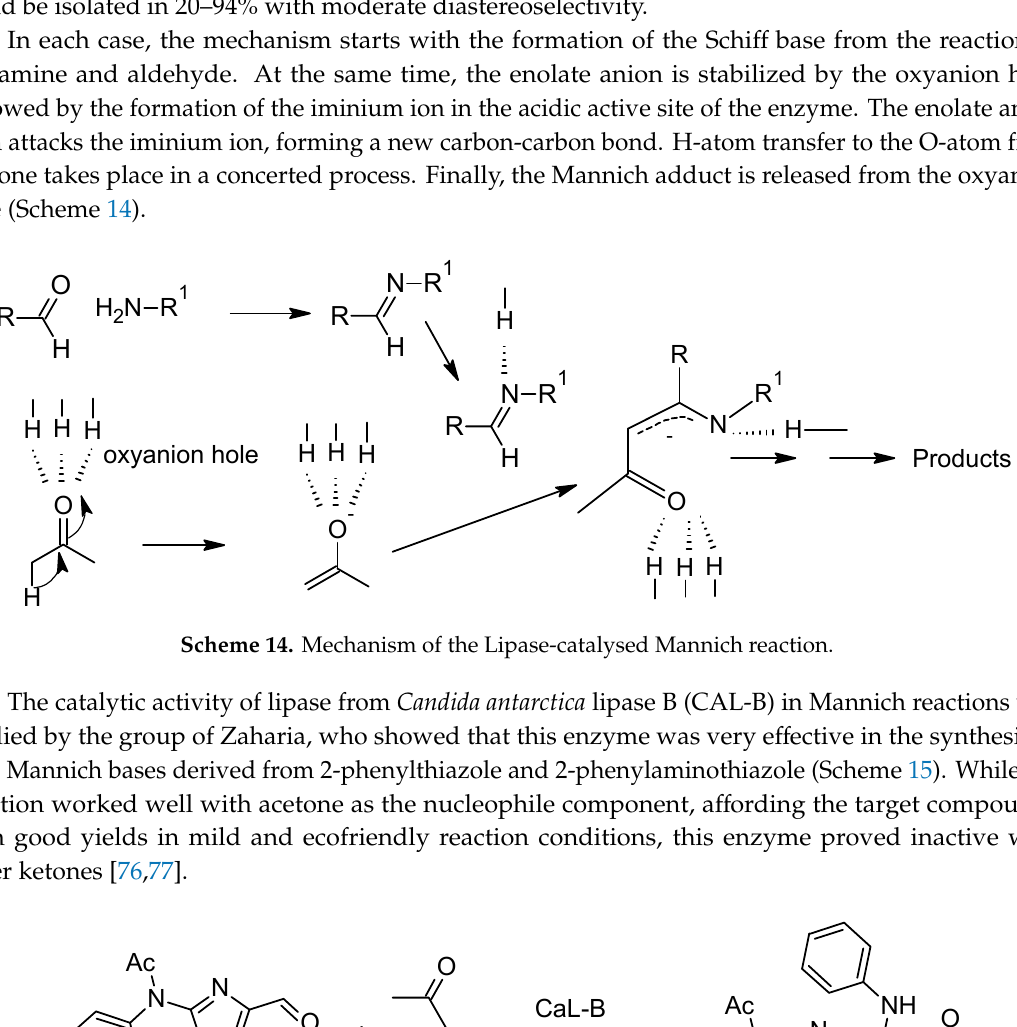
ProductsH ProductsH